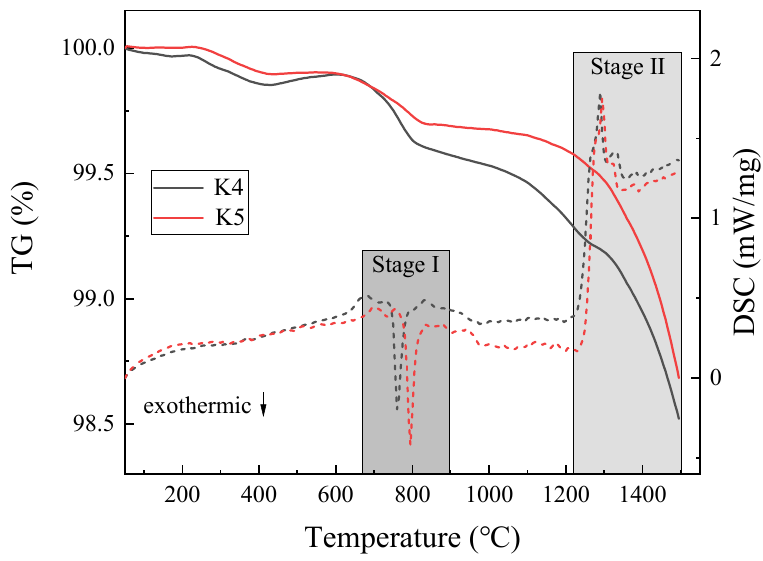
Figure 5. The TG (solid line) and DSC (dotted line) curves of the slag K4 and K5.